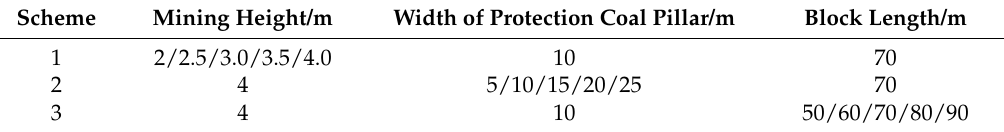
Table 1. Calculation scheme.